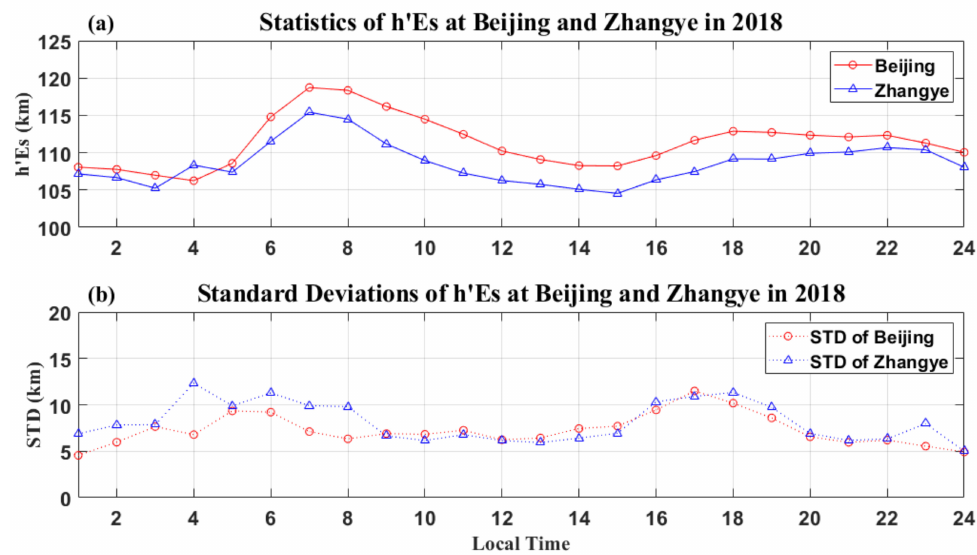
Figure 5. Diurnal variations in mean values ( a ) and standard deviations ( b ) of h’Es at Beijing and Zhangye stations.